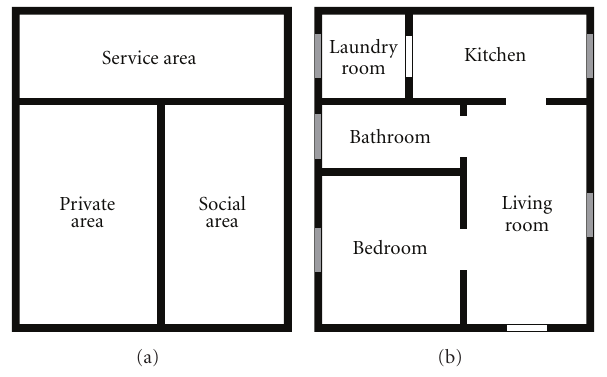
Figure 6: Dividing the total space of the house in three main areas (a): private, social, and service area. Example floor plan generated by the model (b).